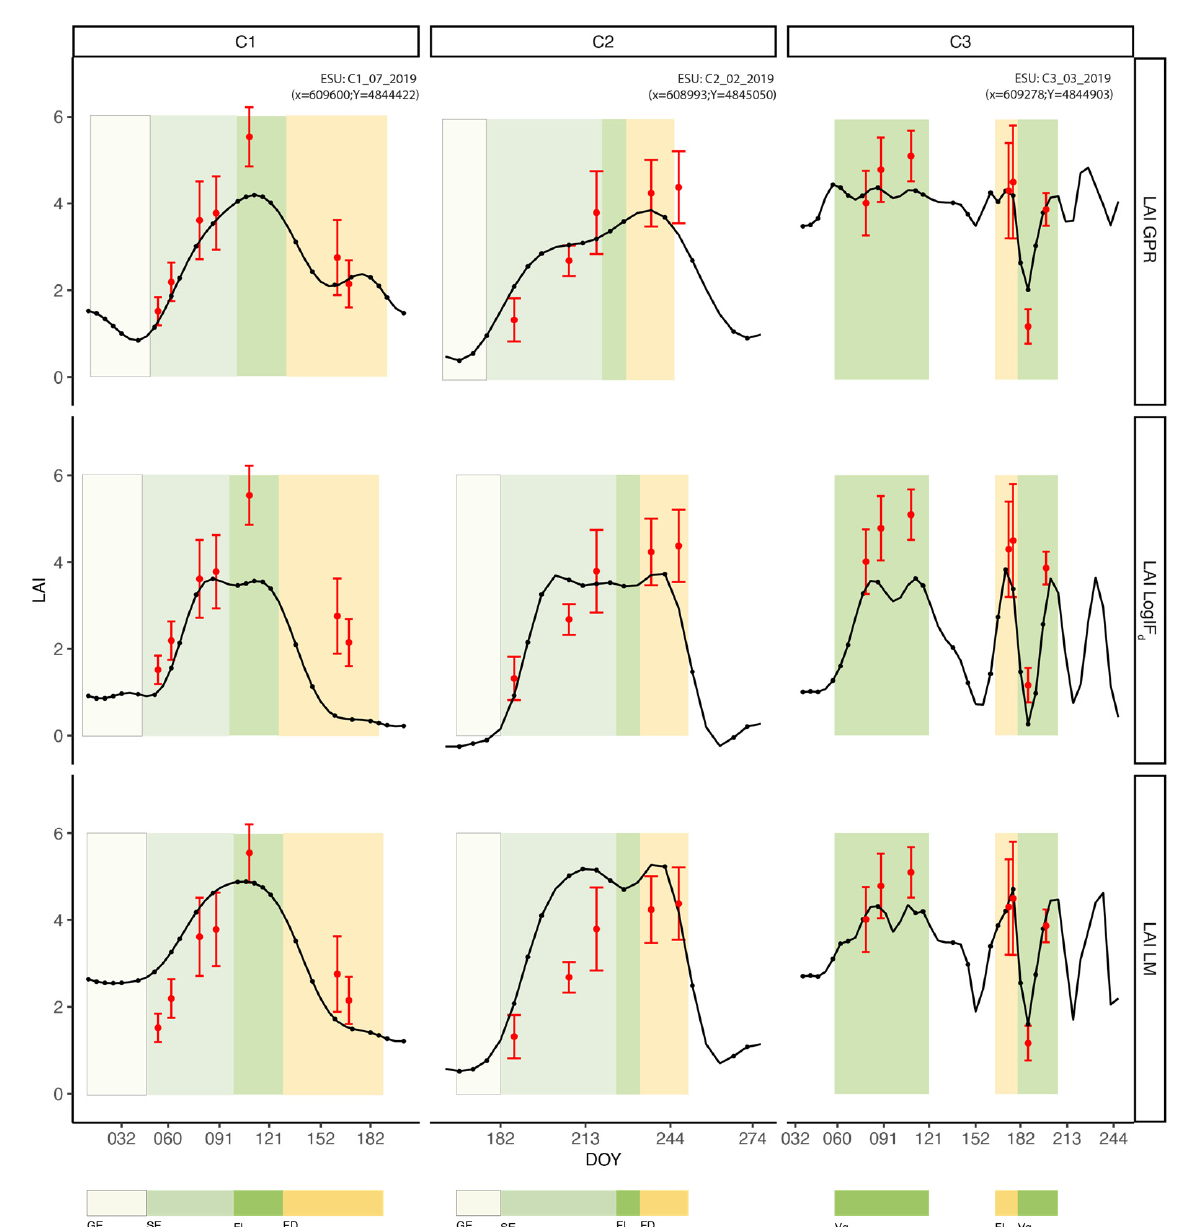
Figure 7. Temporal profile of LAI retrieved with GPR, LM, and LogIF d (black line), compared with the measured ground-LAI (red dots). Black lines represent the smoothed temporal profile of each crop using the GPR interpolation method, while black dots are the available S2 images. Red bars represent the standard deviation of ground-LAI. Different colored areas indicate the duration of each growth stage. In winter wheat (C1) and maize (C2), the growth stages are: from germination to full emergence (GE); stem elongation (SE); flowering (Fl); and fruit development (FD). In alfalfa (C3), the growth stages are: vegetative (Vg), occurring after mowing and flowering; and (Fl) occurring at full canopy development before mowing. In the x -axis, the day of the year (DOY) is depicted.